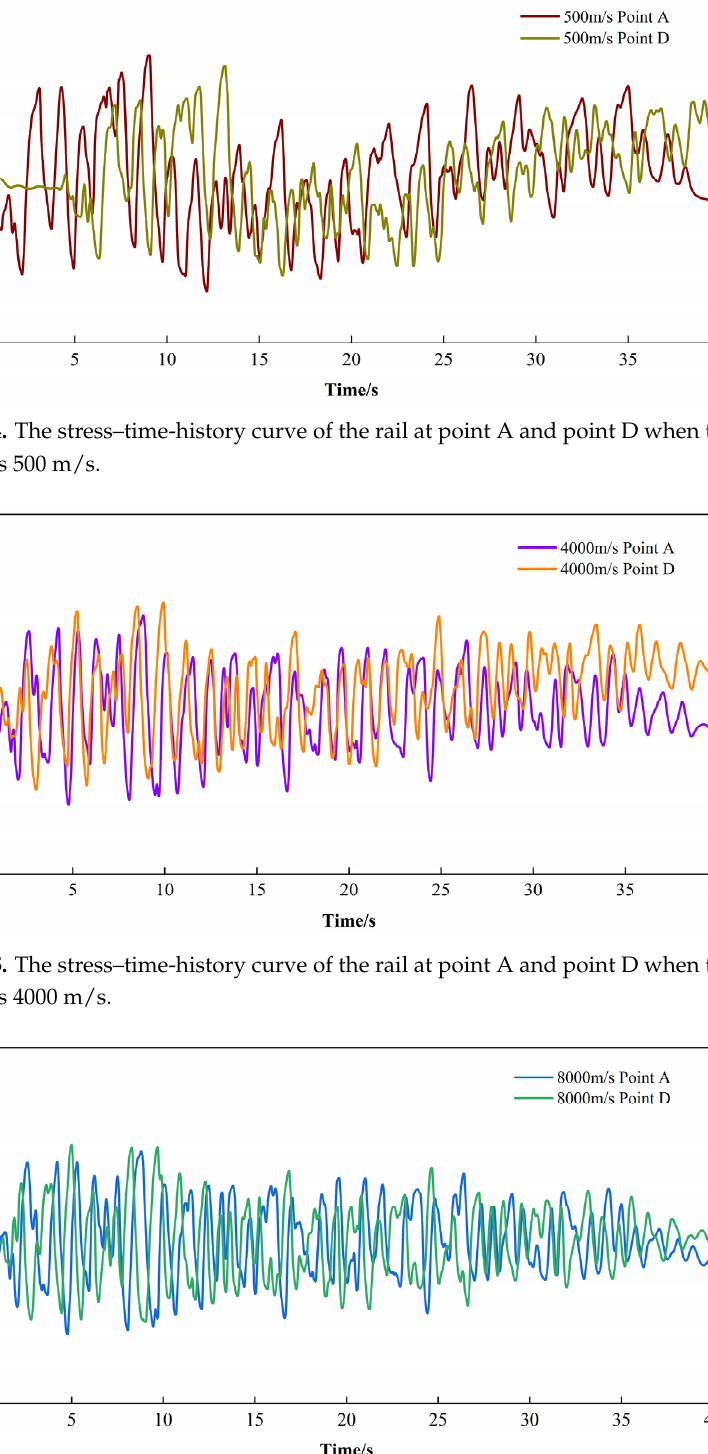
Figure 17. Stress–time-history curves of rails at points A and D under consistent excitation. Figure 18 shows the comparison of the rail stress time course curve at point D with the original curve when the apparent wave speed is 200 m/s shifted forward by 9.42 s. It can be seen that the curve is almost identical and there is a hysteresis.